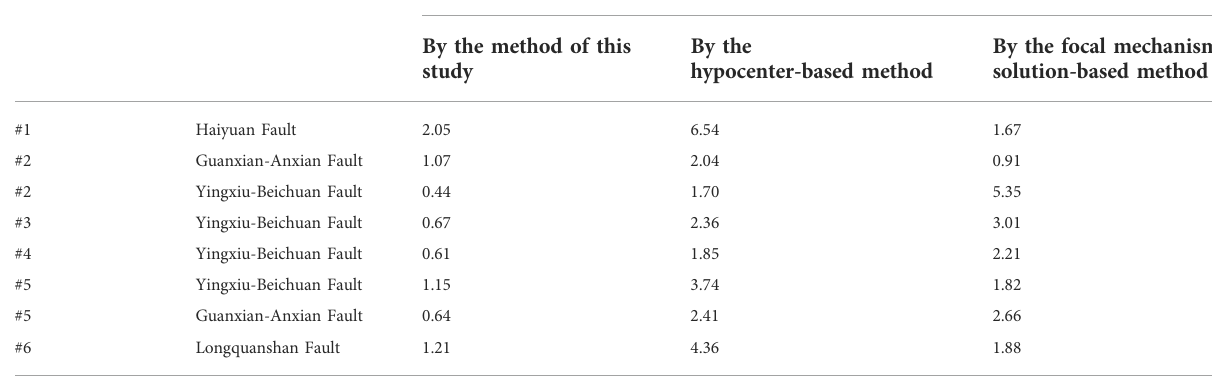
TABLE 4 The RMSE between the geophysical interpretation results and the fi tting results based on different methods. Pro fi le index Fault name RMSE of the ruptured seismogenic fault models/km